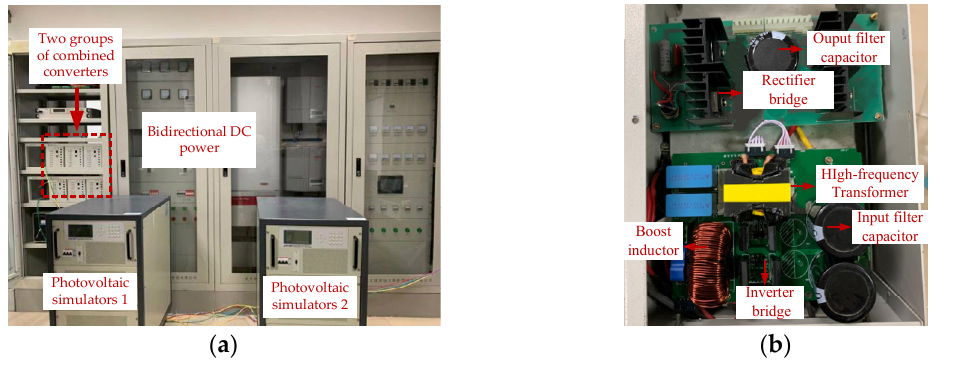
Figure 12. The testing platform of the PV DC boost collection: ( a ) composition of the experimental platform and ( b ) internal parts of the sub-module.